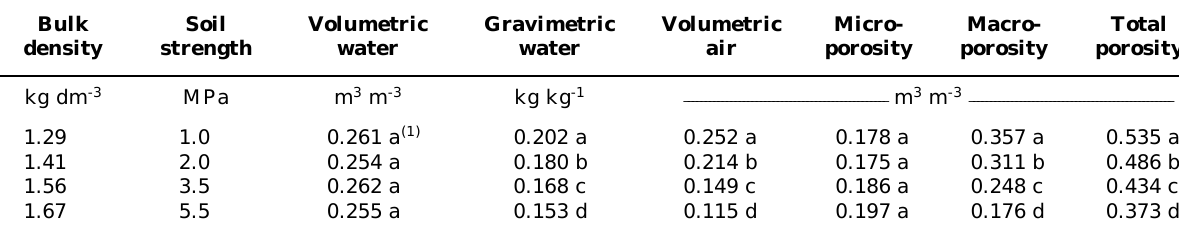
(1) Means followed by same letter within a column are not significantly different at the 0.05 level according to Duncan test.